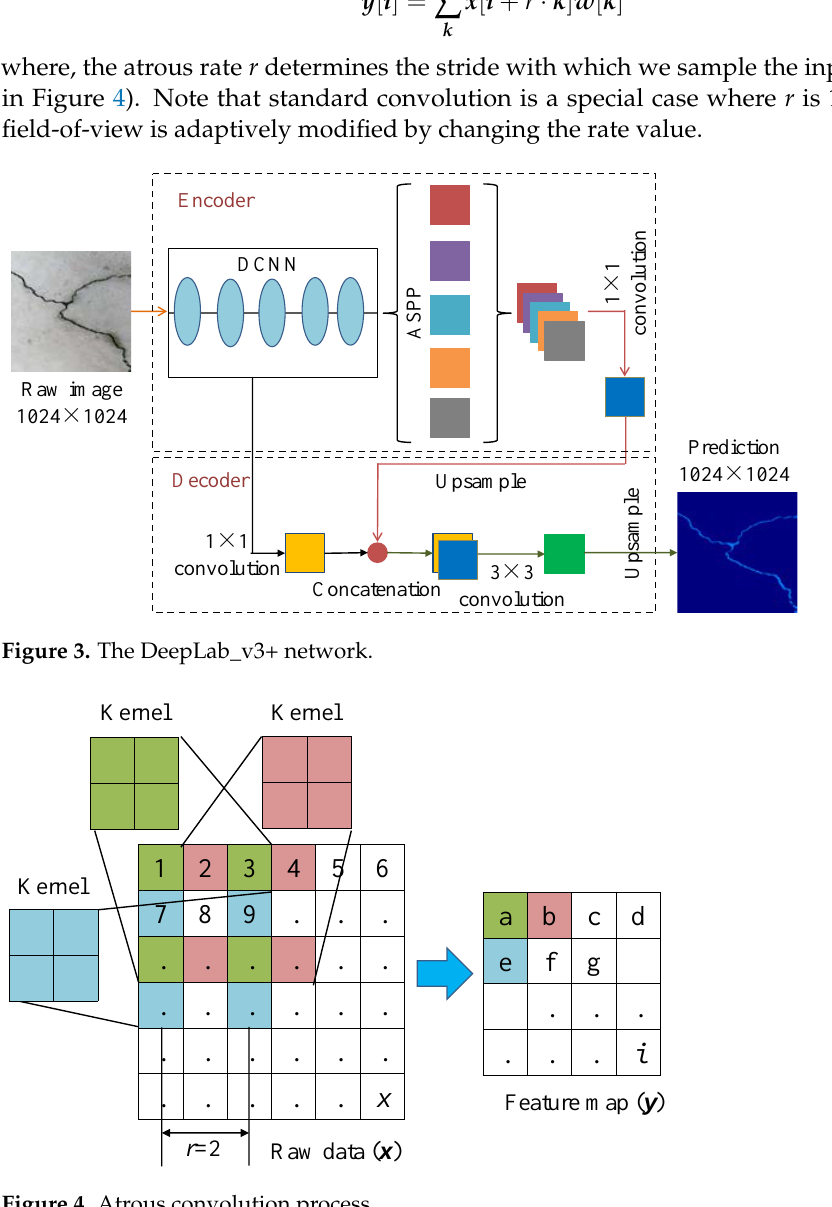
Figure 4. Atrous convolution process.